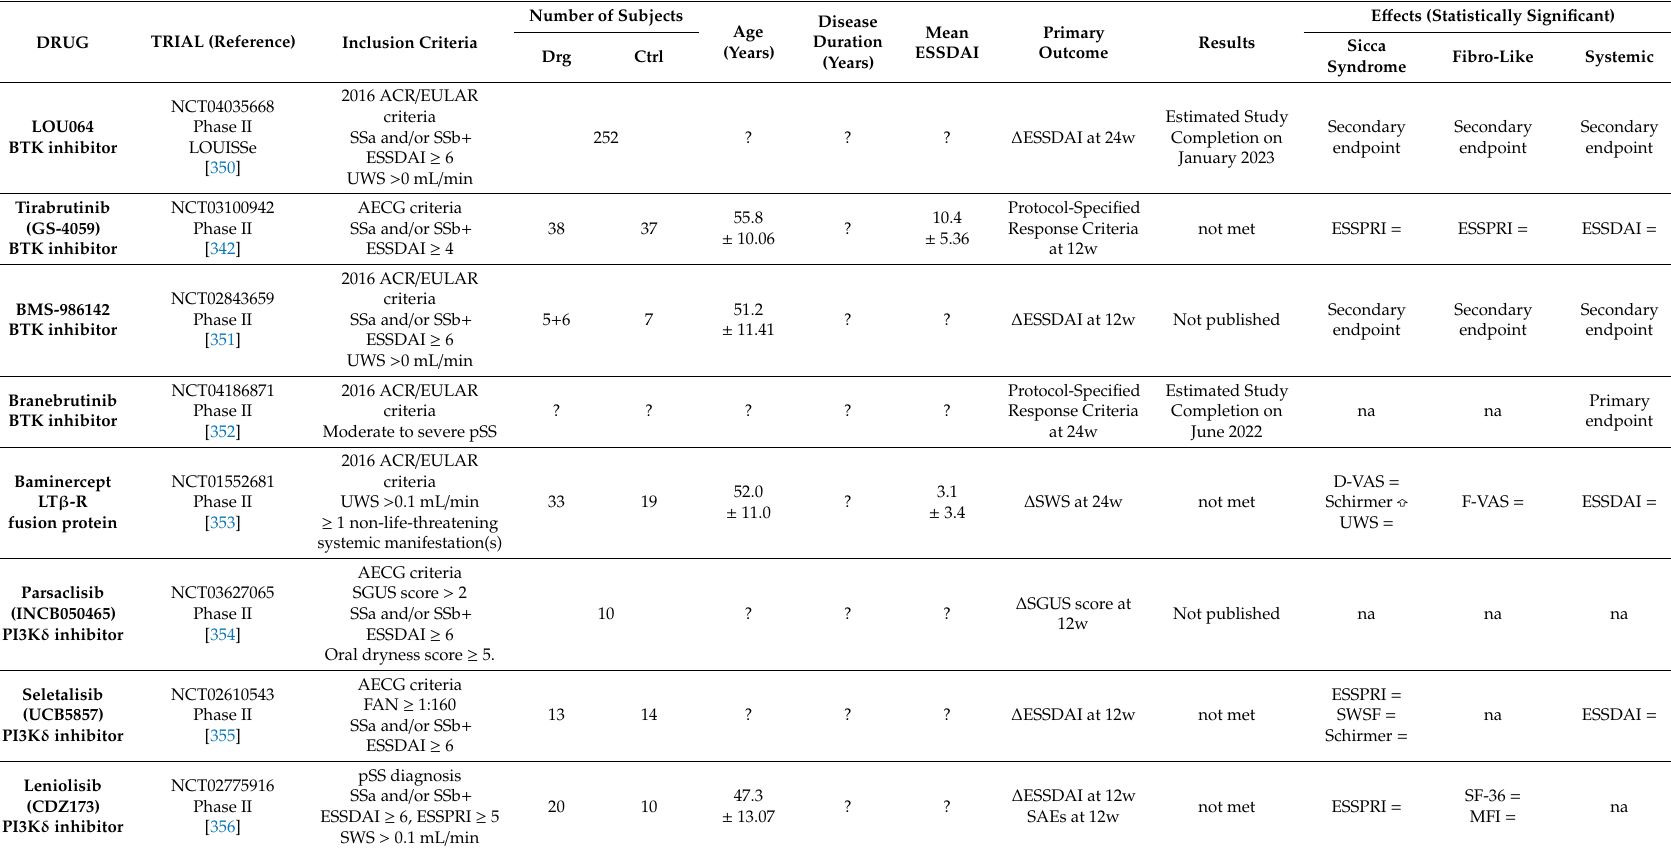
Table 8. B cell targeted drugs in pSS part 3: drugs targeting other B cells survival and function